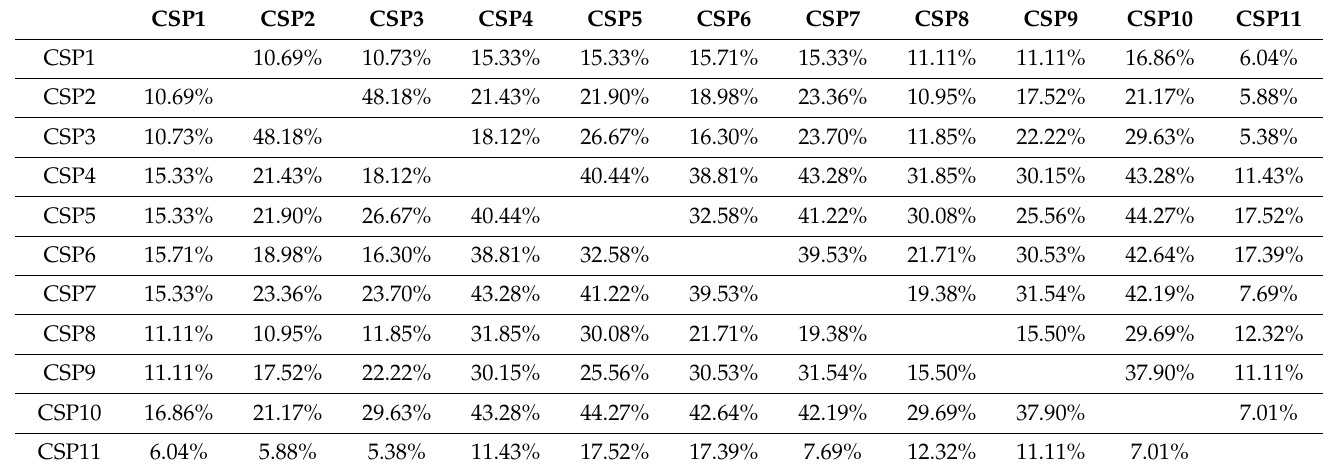
Table 4. The similarity of 11 O. communa CSP amino acid sequences.